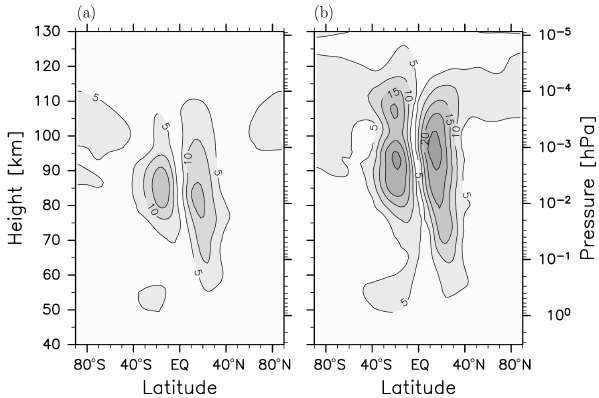
Figure 1. Amplitudes of the migrating diurnal tide in the merid- ional wind from the free-run simulation with (a) the fourth-order horizontal diffusion and (b) the eighth-order horizontal diffusion for the time period from 15 January to 20 February 2017. The contour interval is 5ms − 1